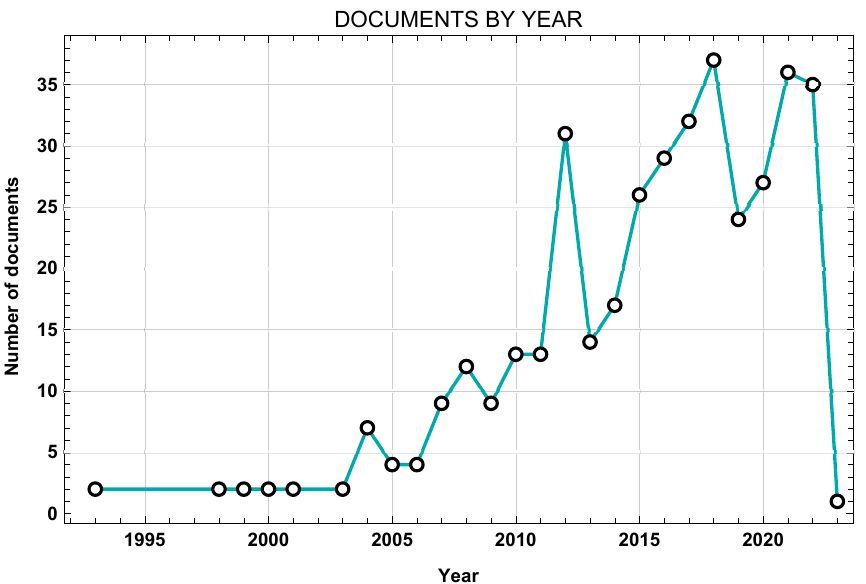
Figure 3. Network visualization of title, abstract, and keywords.